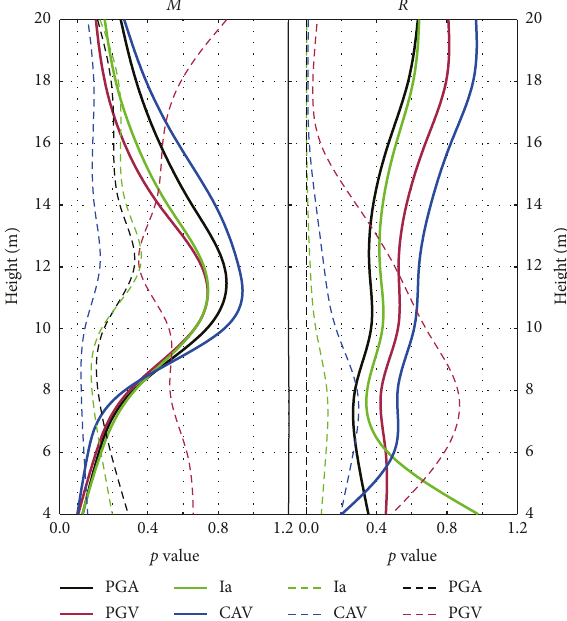
Figure 19: Sufficiency comparison of IMs under pulse-like and far- field ground motions. The solid lines and dashed lines refer to the cases under pulse-like and far-field ground motions,